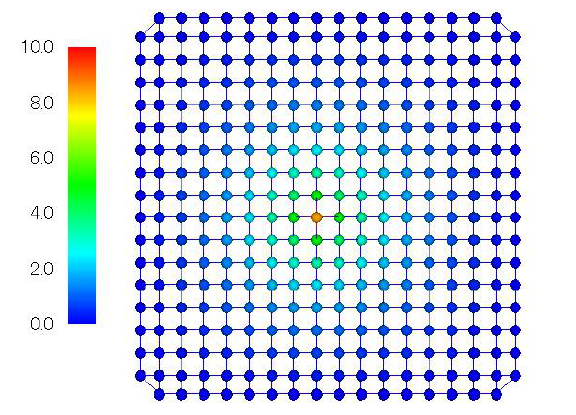
Figure 7. Simulated results of deformation of string bed at point A (force = 100 N).